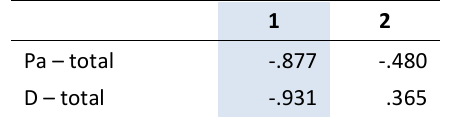
Table 14: Canonical loadings for the LD and Pa set